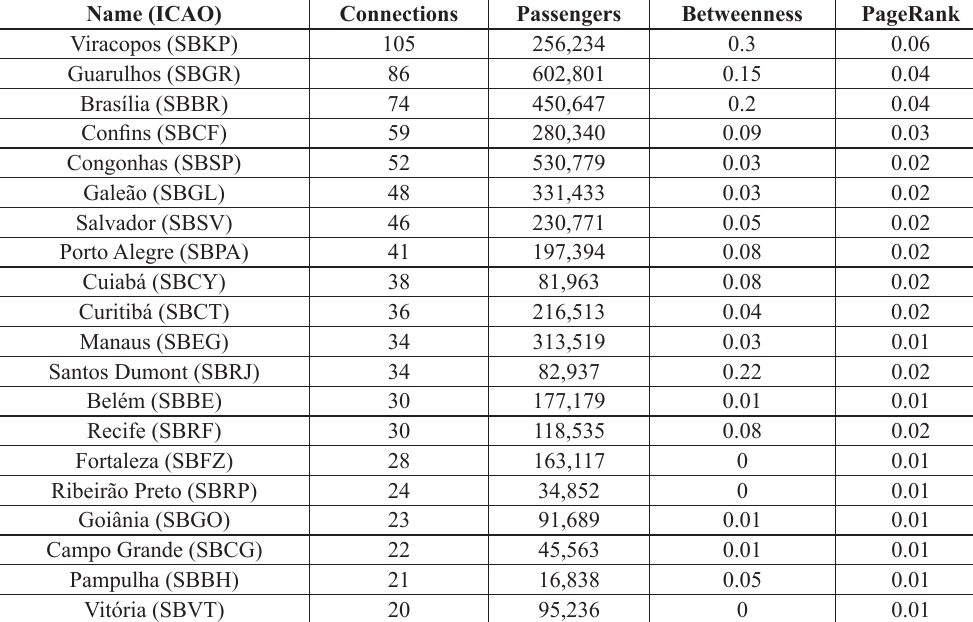
Top-20 Airports - Number of Connections - National